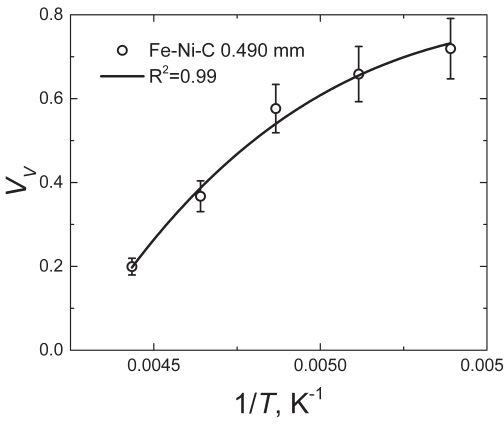
Fig. 6 – Volume fraction of martensite plates per unit of volume against transformation temperature. Fe-32wt%Ni-0.004wt%C alloy 5 with a mean intercept length of austenite grains equal to 0.490 mm. Solid line corresponds to the model developed here: equation 9. Error bars corresponding to an estimated relative error of ±10% were added to the plot.